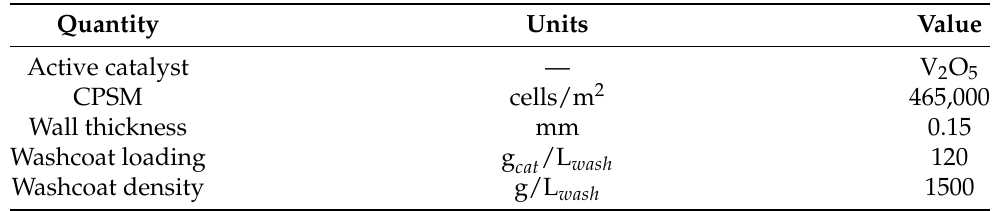
Table 5. The fixed characteristics of marine SCR devices considered in this analysis. The washcoat loading and washcoat density values are similar to those used in automotive SCRs